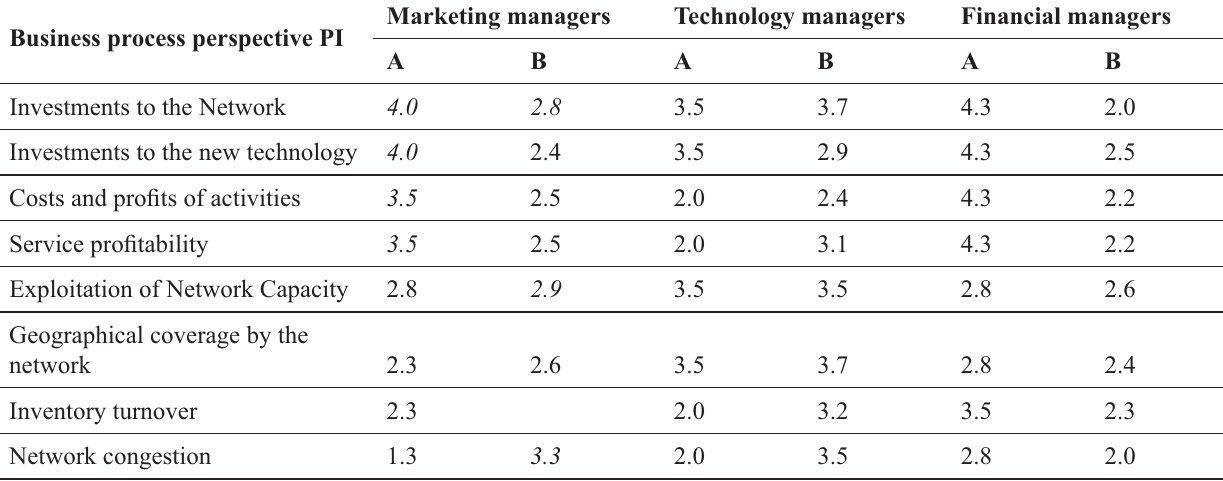
Table 4. Business Process perspective PI usage by managers of companies A and B